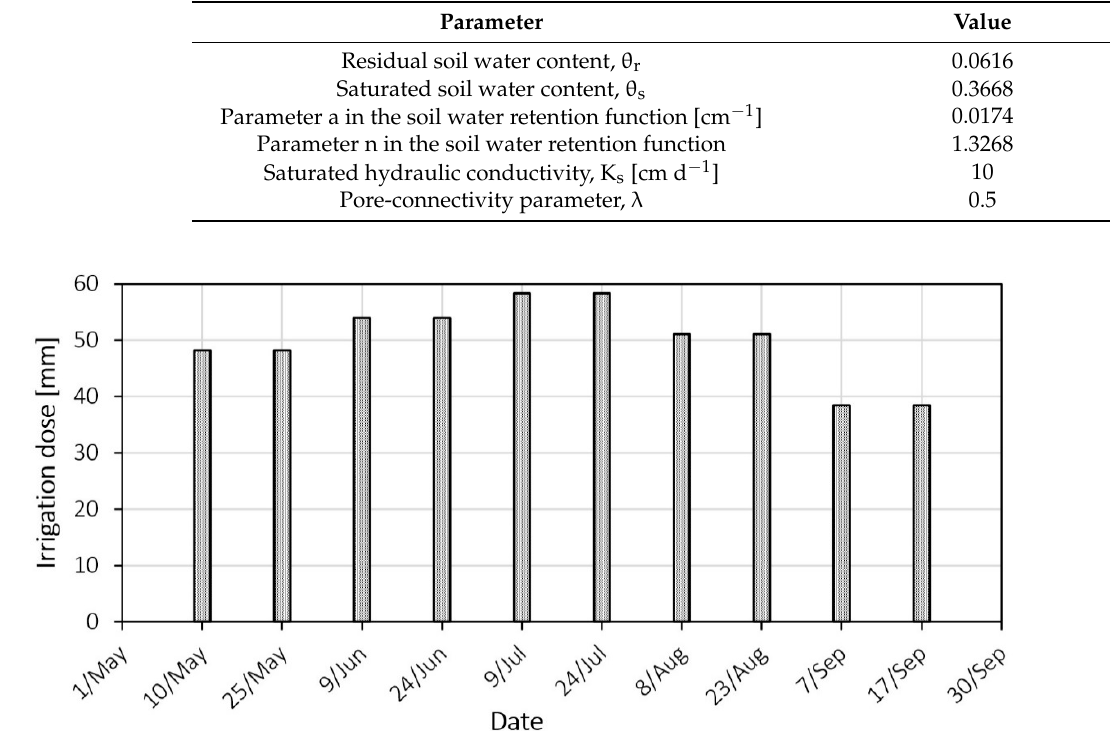
Figure 2. Irrigation dose applied as boundary condition at the top of soil